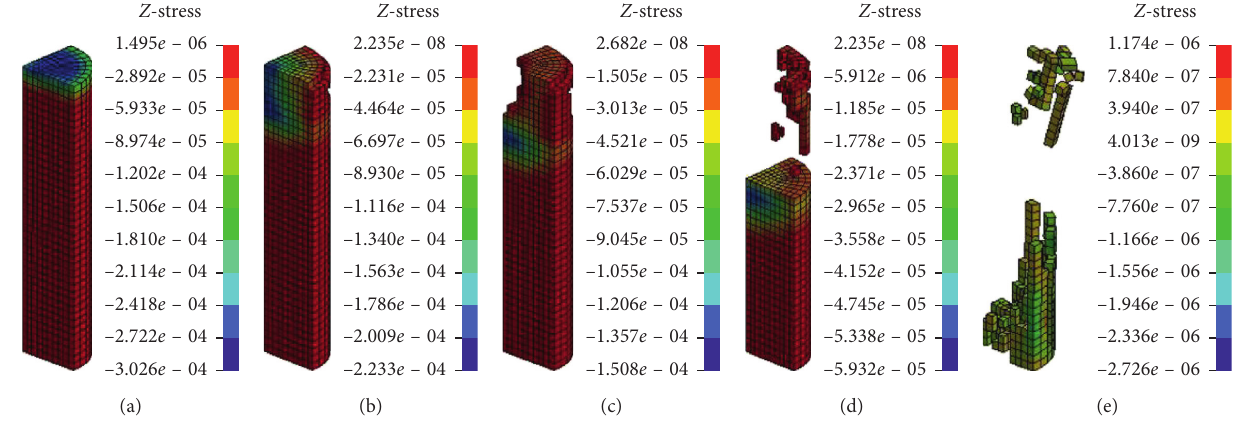
Figure 12: Distribution of the axial stress at a velocity of 10m/s. (a) 3 μ s. (b) 13 μ s. (c) 18 μ s. (d) 29 μ s. (e) 1000 μ s.